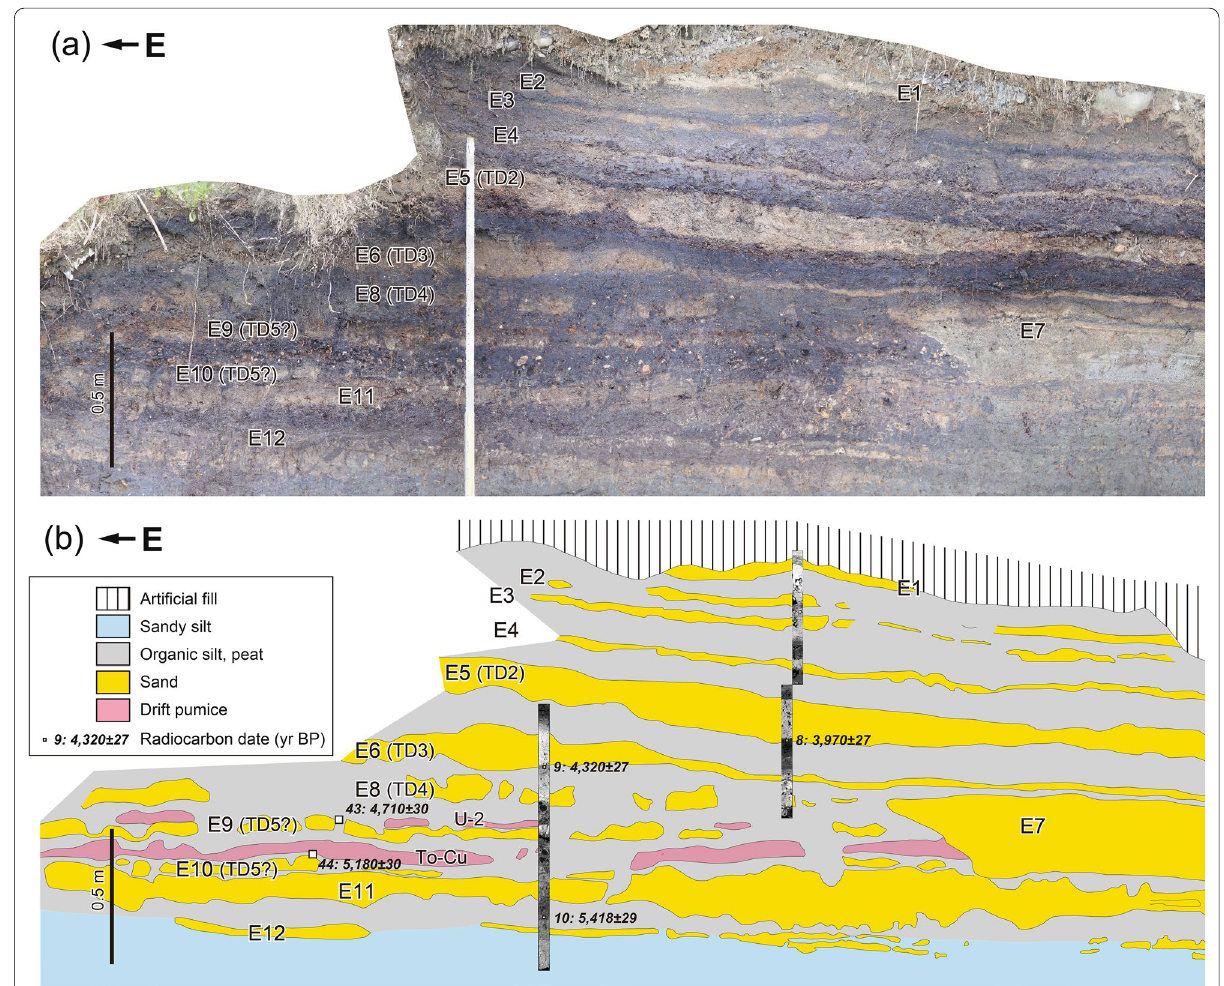
Fig. 2 SKN-E outcrop. a Photograph of SKN-E outcrop. b Sketch of SKN-E outcrop. Grayscale columns on the sketch are XCT images. a , b are of the same section. The volcanic ash of the To-Cu tephra is too thin to depict in ( b